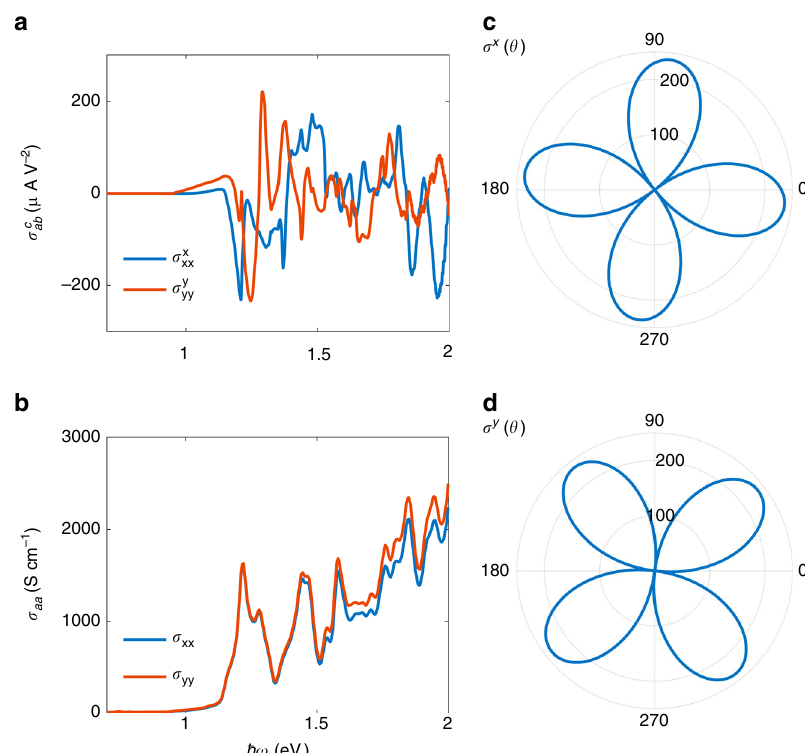
Fig. 2 Calculated photoconductivity in response to the linearly polarized light. a The photon energy ( ħ ω ) dependence of σ x xx and σ y yy . b The linear-response optical conductivity σ xx and σ yy . c , d The angle dependent photoconductivity σ x ( θ ), σ y ( θ ) [cf. Eq. (3)] in the same unit as a for ħ ω = 1.2 eV and ħ / τ = 1 meV. x and y are the directions of the current and θ is the angle between the electric fi eld of light and the x